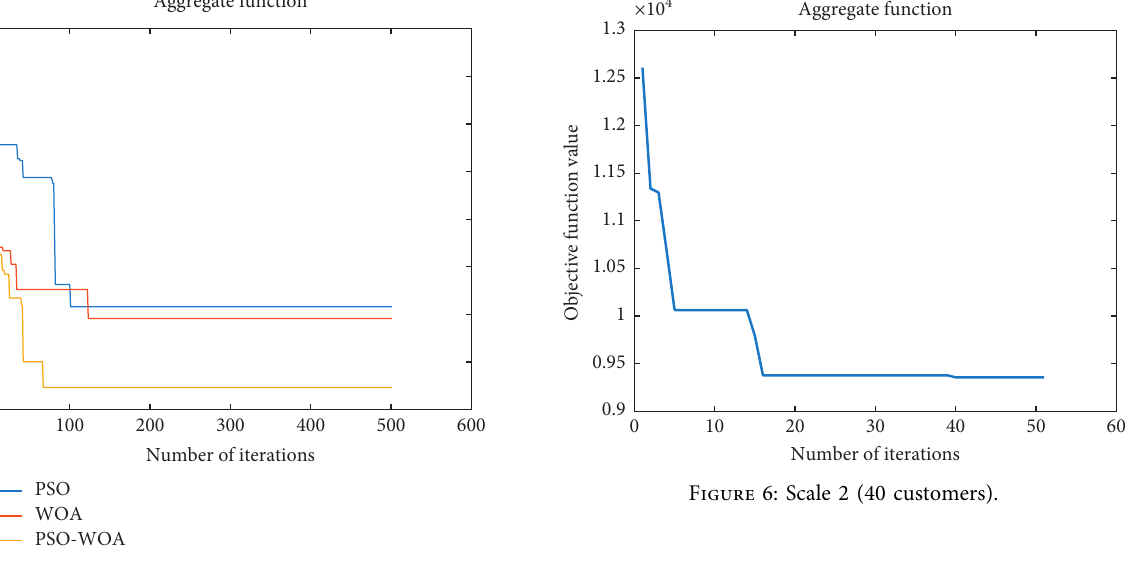
Figure 4: Algorithm comparisons.